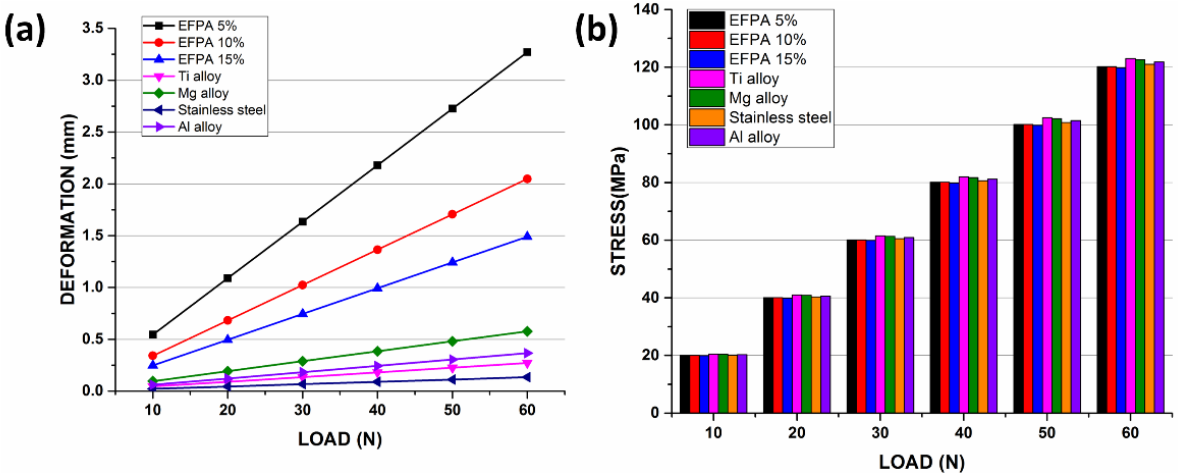
Figure 7. Graphs of Mode-2 showing ( a ) maximum stress vs. load and ( b ) maximum deformation vs. load.